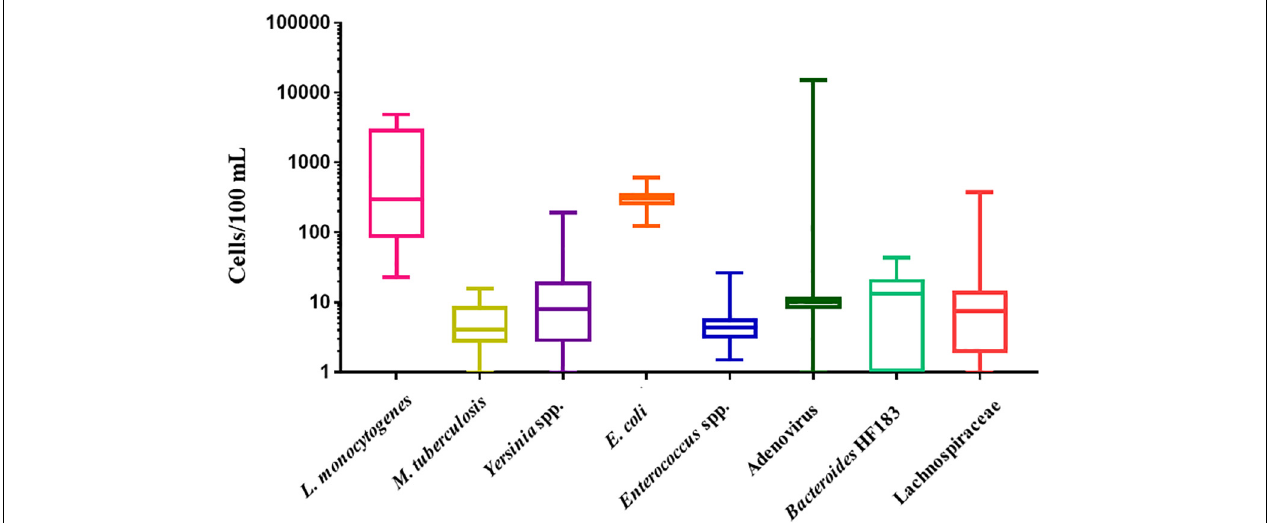
FIGURE 1 | Box and whiskers plot of the concentration (cells/100 mL) for L. monocytogenes , M. tuberculosis , Yersinia spp., E. coli , Enterococcus spp., adenovirus, Bacteroides HF183, and Lachnospiraceae. The whiskers illustrate the minimum and maximum, the outer box illustrates the 1st and 3rd quartiles, and the inner line illustrates the